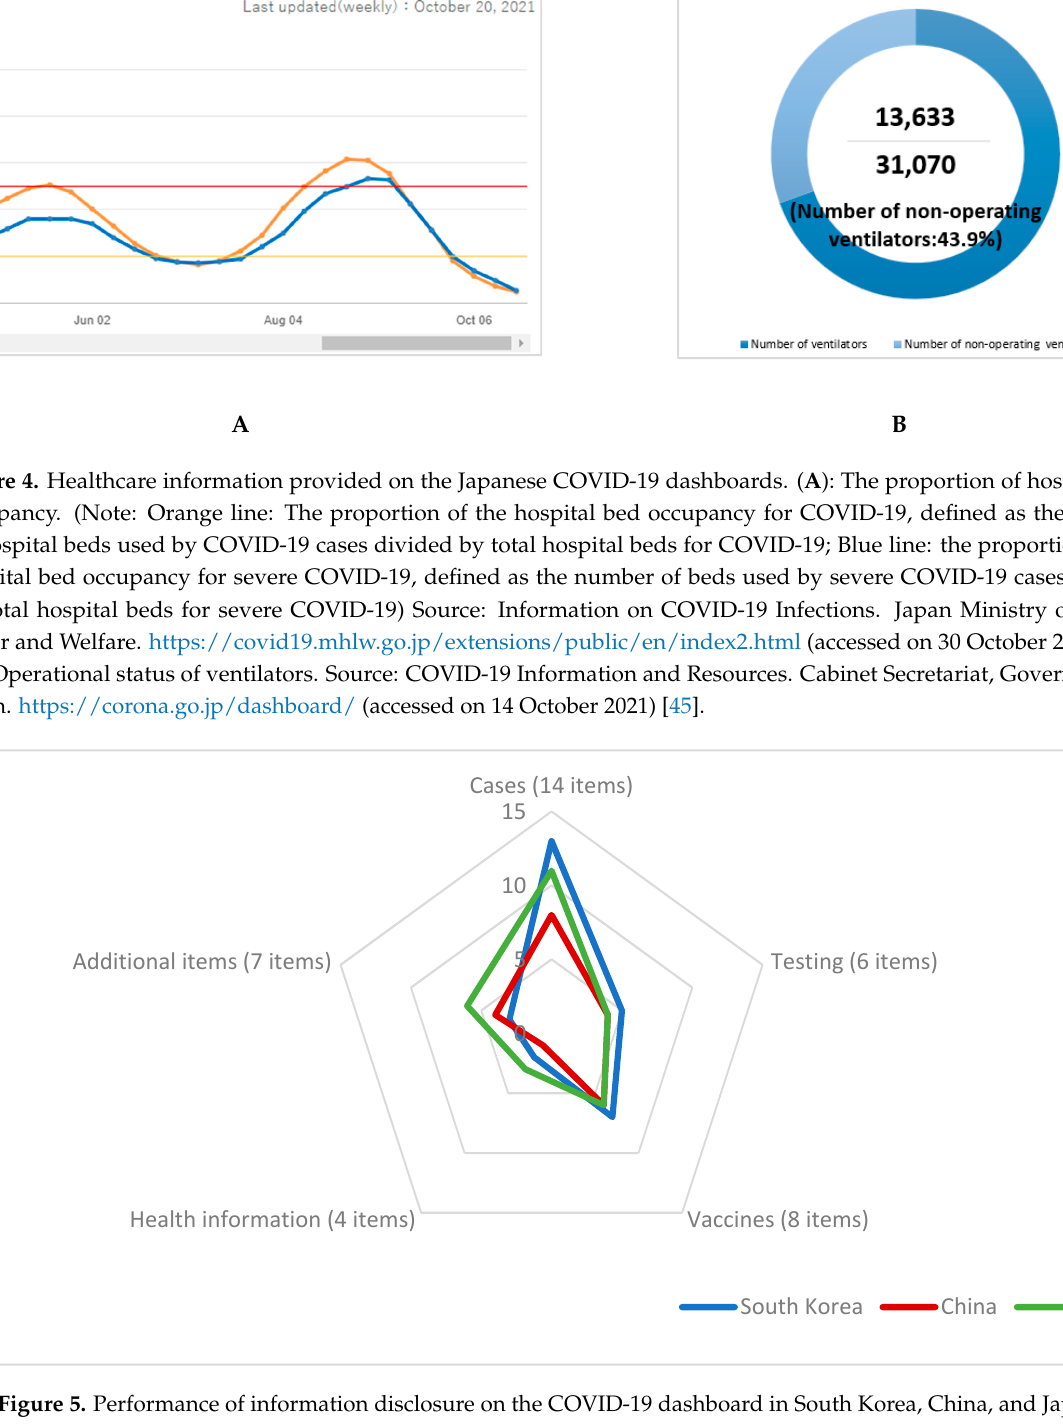
Figure 5. Performance of information disclosure on the COVID-19 dashboard in South Korea, China, and Japan.